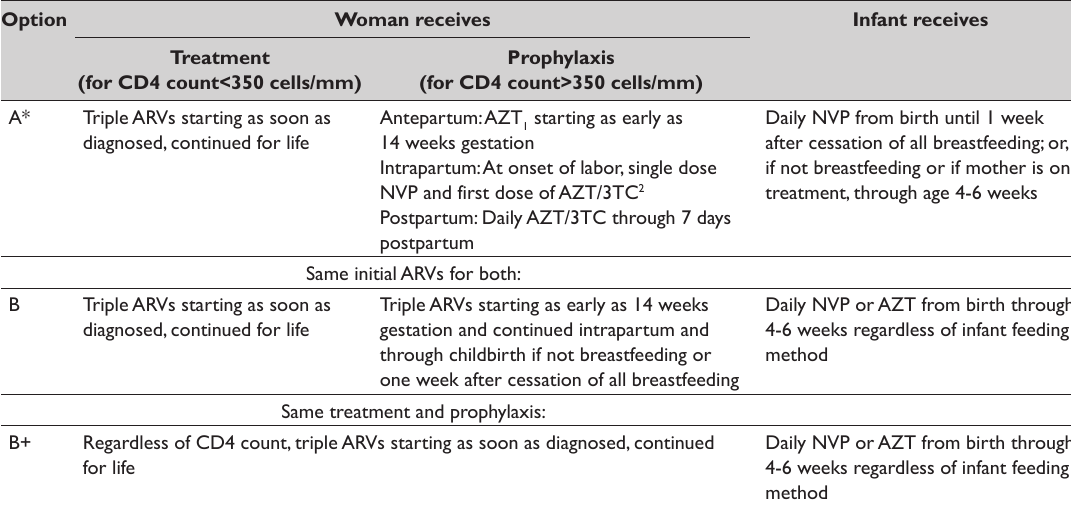
Table 1: WHO options for PMTCT programs at the time of the study in 2014